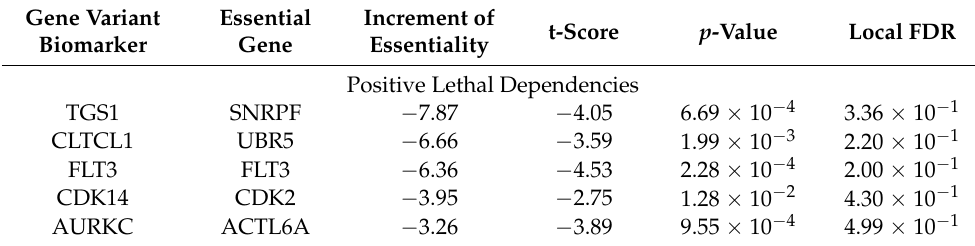
Figure 4. Gene variants-based treatment guidelines in acute myeloid leukemia. ( A ) Volcano-plot of lethal dependencies, LEDs, related to NRAS genetic mutations (left; MUT) and wildtype (right; WT) phenotypes. Increment of Essentiality and − log10 ( p -value) are shown on X-axis and Y-axis, respectively. ( B ) Histogram of p -values for 6 genetic sequence variants in acute myeloid leukemia. NRAS-alteration is enriched in close to zero p -values, which is the basic concept of HUGE-based statistical approach. All genetic variants histograms of p -values can be found in the Supplementary Material. ( C ) Summary of the computational predictions validated: NRAS-altered cells were predicted to be sensitive to siNRAS and resistant to siPTPN11. Conversely, NRAS-wt cells were predicted to be sensitive to siPTPN11 and resistant to siNRAS. ( D ) Tumor proliferation of the four AML cell lines after inhibiting NRAS (siNRAS) and PTPN11 (siPTPN11) with specific siRNAs. Blue: NRAS-altered AML cell lines (HL-60 and OCI-AML3); Orange: NRAS-wild-type AML cell lines (MV4-11 and HEL). Table 1. Ranking of lethal dependencies in AML using the covariate-based statistical approach. The ranking is divided into three groups regarding the typology of the lethal dependency relationship: Positive Lethal Dependency (PLD), Negative Lethal Dependency (NLD) or Dual Lethal Dependency (DLD) (Figure S1). The Increment of Essentiality column represents the average variation in the DEMETER score between altered and wild-type cells, and its sign is related to the lethal dependency relationship. Lethal dependencies that share the same essential gene and the same Increment of Essentiality sign were omitted in this table (see complete data in Supplementary Table